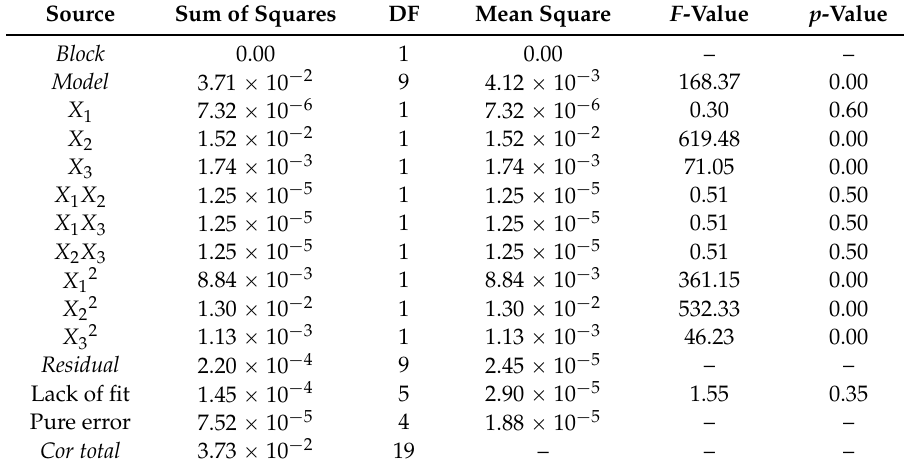
Table 3. ANOVA of response surface quadratic model for the extraction yield of the essential oil from T. chinensis var.